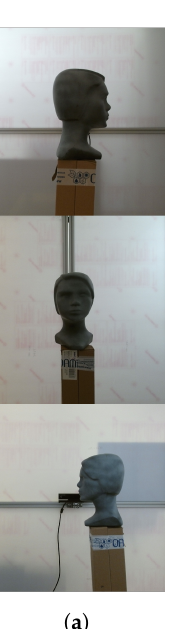
Figure 5. The images from three Kinect v2 ToF camera: ( a ) RGB images. ( b ) Ground truth depth images. ( c ) 3D reconstructed model from ground truth depth images. ( d ) Construction of scanning cabin with placement of cameras, configuration for three cameras.